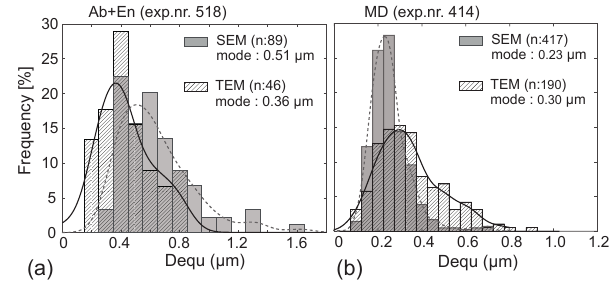
Figure 11. Grain size distributions of plagioclase in shear bands. (a) Ab+En experiment 518 and (b) the Maryland diabase experi- ment 414. 2-D grain size distributions (GSDs) in both samples are determined on BSE–SEM images and TEM images separately. n : number of grains; solid black (TEM) and dashed grey lines (SEM) are kernel density estimate fits to the GSDs and modes determined from the fit are given in the